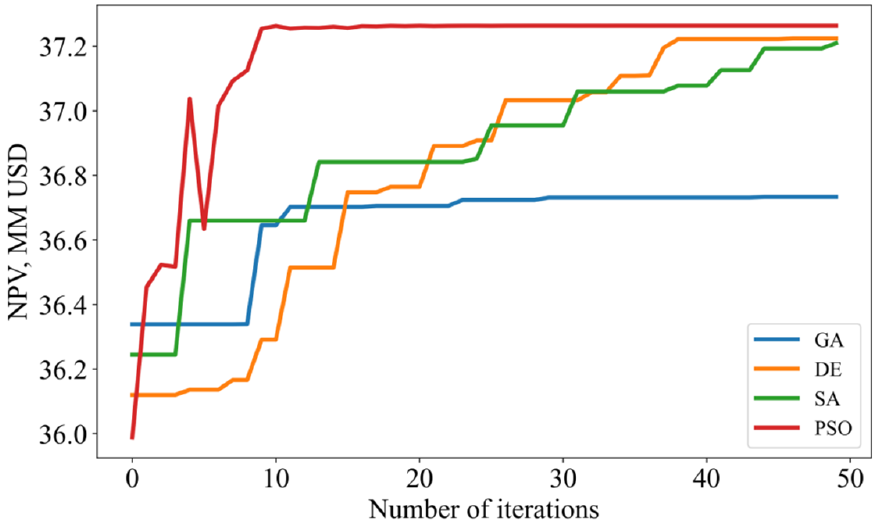
20 of 24 ( c ) Effective fracture permeability. ( d ) Average fracture height/reservoir height. Figure 13. Sensitivity of NPV to fracturing parameters. 4.4.3. Integration of Evolutionary Algorithms and Multilayer Perception In this study, four evolutionary algorithms—GA, DE algorithm, SA algorithm, and PSO—were integrated with the MLP-based production model to optimize the fracturing parameters of the base model (Table 4); the ideal fracturing parameter optimization algorithm was selected by comparing their iteration speeds and optimal NPVs. Table 6 summarizes the final hyperparameters of the four optimization algorithms. Table 6. Final hyperparameters of the four evolutionary models. Evolutionary Algorithm